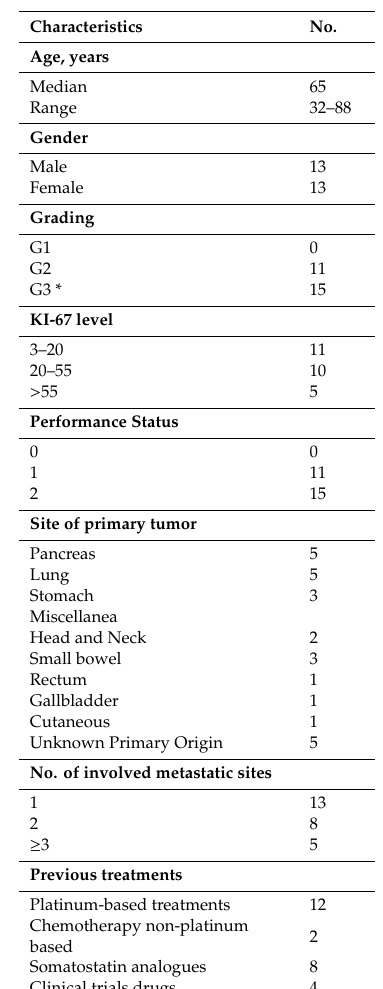
Table 1. Characteristics of patients and